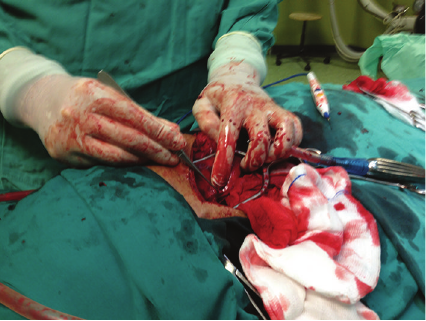
Figure 2: Ligated external carotid artery.